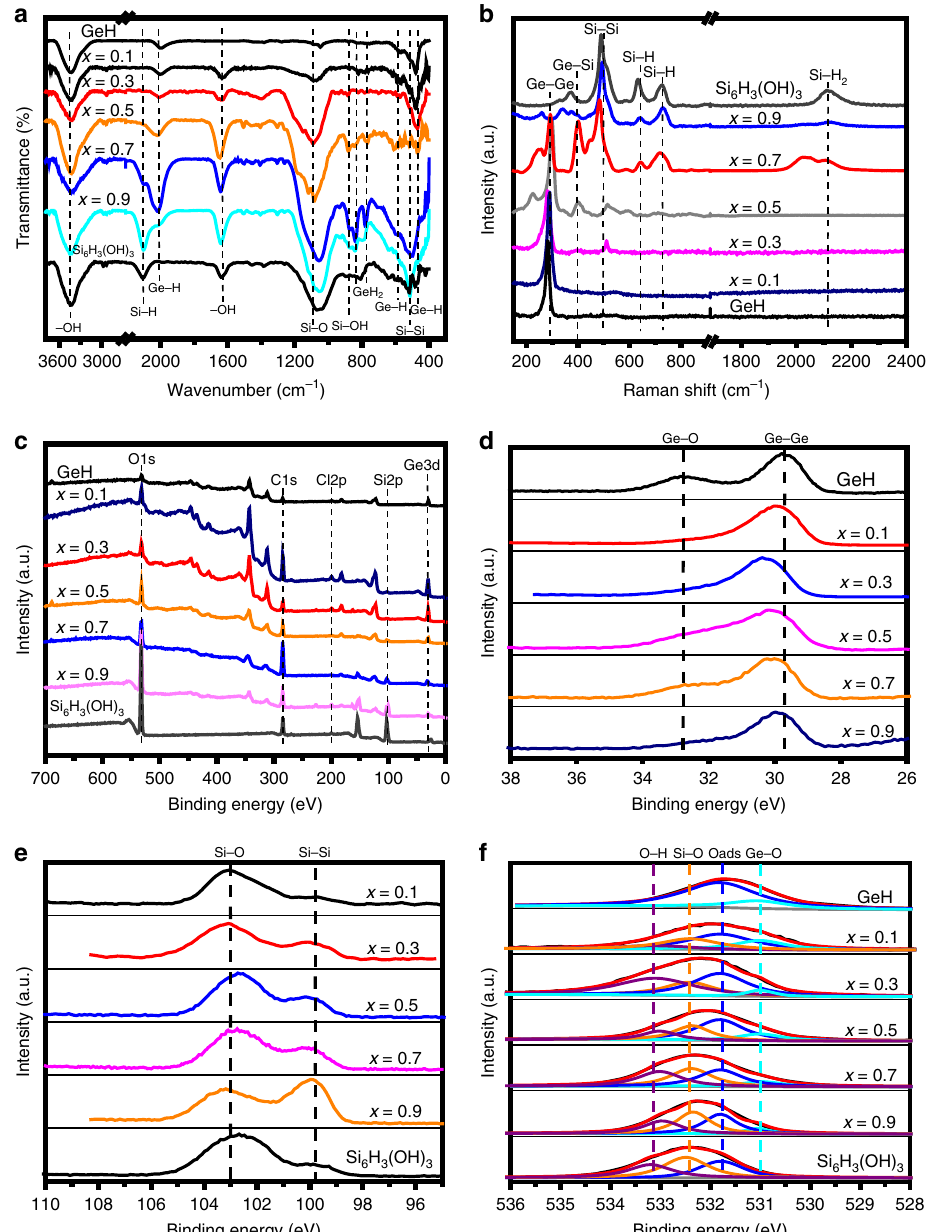
Fig. 4 Chemical structural characterization of gersiloxenes. a FTIR and b Raman spectra of gersiloxenes with different x values, GeH and Si 6 H 3 (OH) 3 . c – f XPS spectra of gersiloxenes ( x = 0.1, 0.3, 0.5, 0.7, 0.9), GeH and Si 6 H 3 (OH) 3 . c XPS survey spectra. High-resolution XPS spectra of d Ge3d e Si2p, and f O1s. Oads represents the adsorbed O at vacancy sites. FTIR Fourier transform infrared, XPS X-ray photoelectron spectroscopy. Source data are provided as a Source Data fi